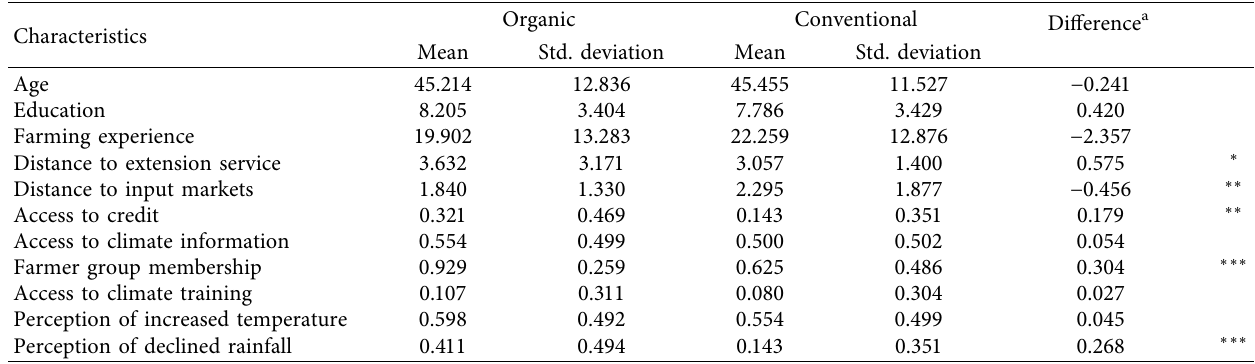
Table 2: Socioeconomic profile of respondent.